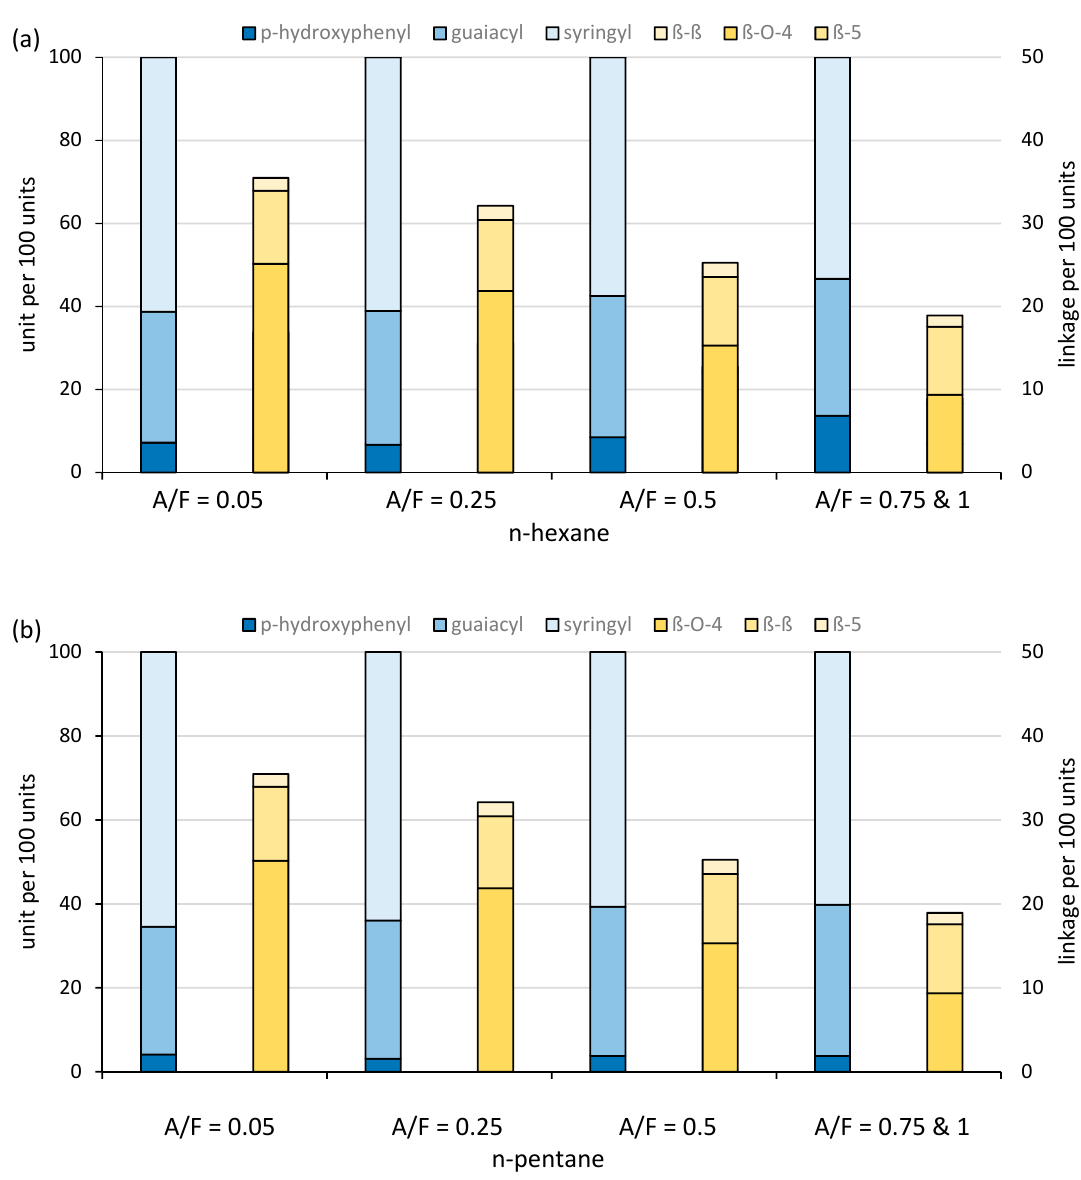
Figure 4. Lignin unit and linkage distribution obtained from 1 H- 13 C-HSQC NMR results for OCL after consecutive precipitation using different antisolvent/feed ratios (A/F) of ( a ) n -hexane and ( b ) n -pentane. (For expansion of HSQC-NMR spectrum see Figure S1 in Supplementary Materials)